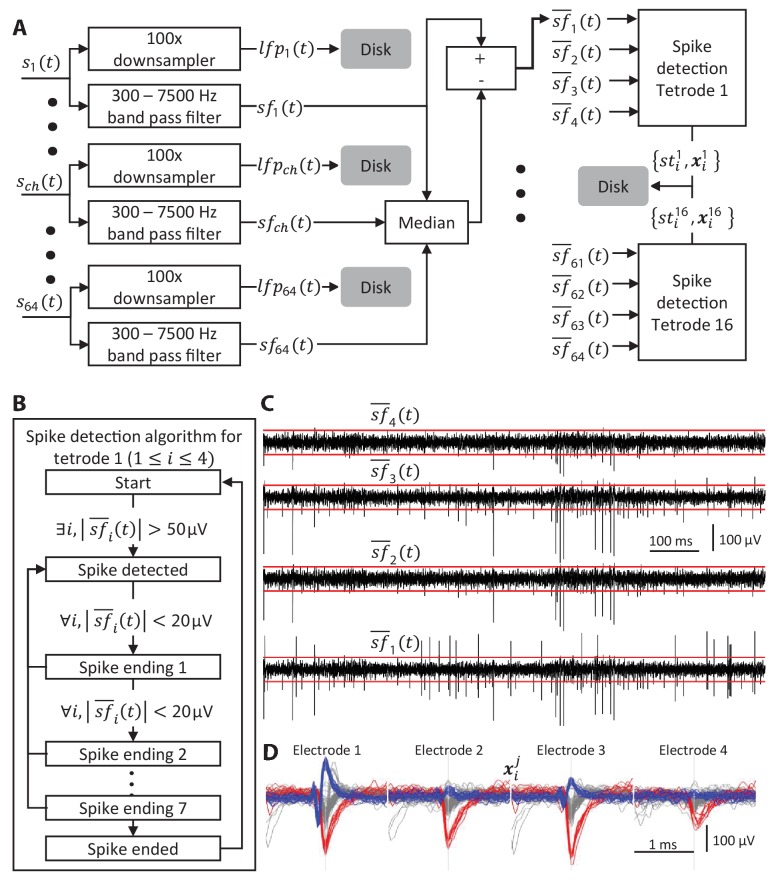
Algorithm for identifying spikes from tetrode recordings.(A) Each input channel sch is split into two streams, one containing the low frequency component lfpch and one containing the high frequency one,sfch. The median of sfch across all channels is subtracted from each channel resulting insf¯ch(t). Spike times stij and spike waveforms xij from each tetrode are then extracted. The LFPs and spikes extracted from the raw data are saved to disk resulting in a 5-10x ‘compression’ of the raw data. (B) Algorithm for detecting spikes. If the absolute value of the filtered signal exceeds 50 µV in any channel of a tetrode then a spike is ‘detected’. The spike is considered to have ‘ended’ if all channels remain within 20 µV for 8 consecutive samples. (C) Example of a 1 s long raw recording from a tetrode. The red lines mark the ±50 µV spike detection threshold. (D) Examples of 2.13 ms wide spike snippets (64 samples) extracted from the data in C. Snippets from all 4 electrodes detected using the state machine in B are aligned to the peak of the spike waveform and concatenated to produce the 256 sample spike waveformsxij.